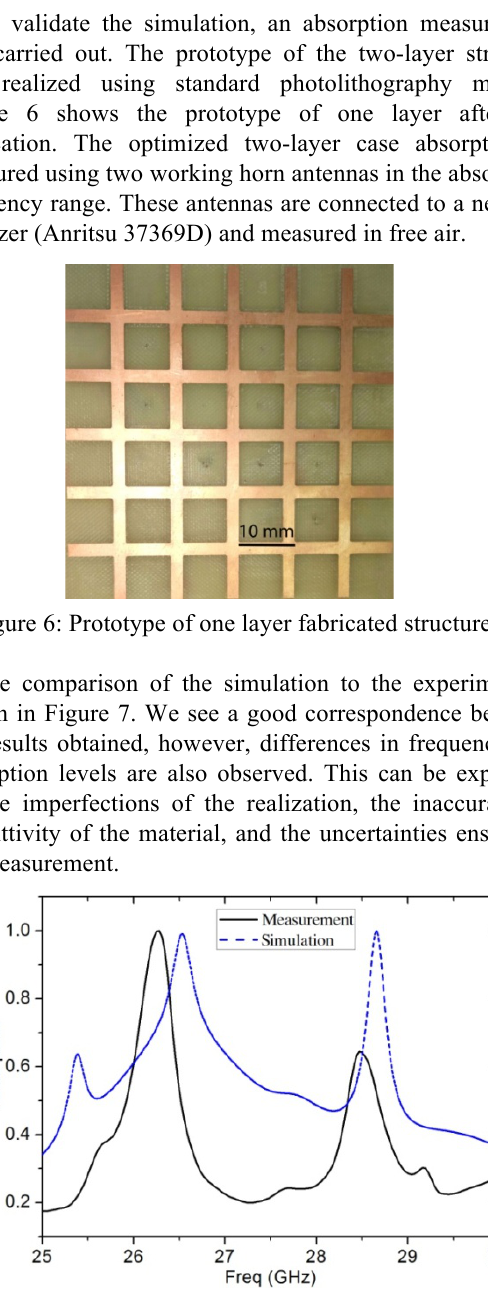
Figure 7: Results of measurement and simulation of the two-layer